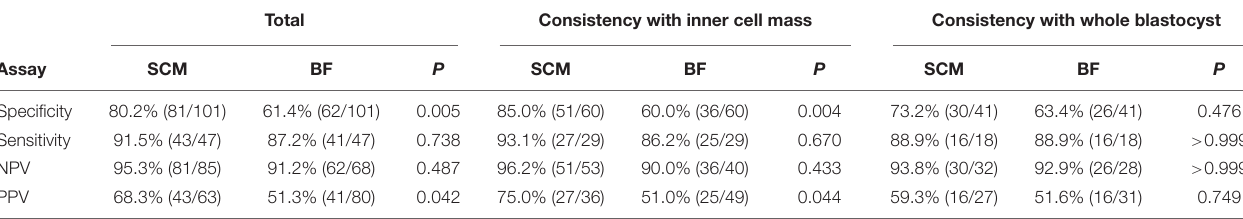
FIGURE 2 | Flowchart of sample processing success and loss. In total, 212 of 218 blastocysts were fully re-expanded. Blastocentesis failed in 38 full-expanded blastocysts. No valid sequencing data (low reads number) were generated in an additional 26 blastocysts. Inner cell mass was available as a reference for 89 blastocysts, and whole embryo was used as a reference for the remaining 59 blastocysts. Among the 148 blastocysts with both SCM and BF data, 101 were euploid, and the remaining 47 were aneuploid. TABLE 1 | The diagnostic performance of NGS of spent culture medium and blastocoel fluid DNA for aneuploidy/mosaicism. Total Consistency with inner cell mass Consistency with whole blastocyst